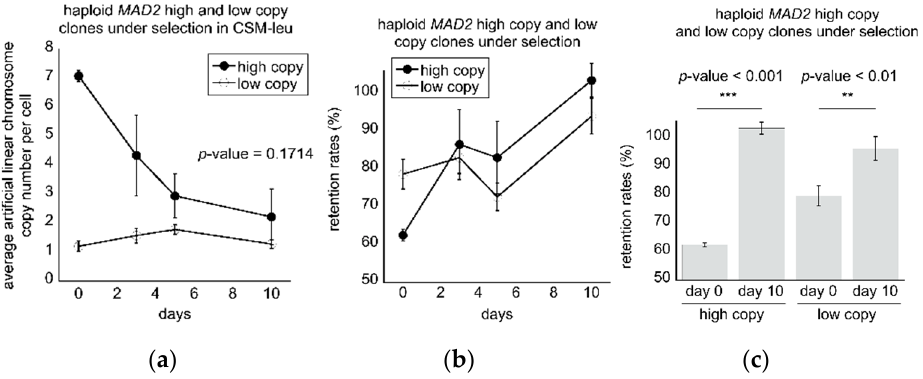
Figure 3. Wild type MAD2 haploid high copy-low retention rate clones evolved towards low copy-high retention rate clones under CSM-leu selection: ( a ) A comparison of average chromosome copy numbers in 2 high copy-low retention rate MAD2 clones with 3 low copy-high retention rate MAD2 clones over 10 days where values are displayed as the mean ± standard deviation. At day 10 there is no significant difference in the artificial chromosome copy numbers per cell ( p -value = 0.1714, Student’s t -test); ( b ) A comparison of 2 high copy-low retention rate MAD2 clones with 3 low copy-high retention rate MAD2 clones over 10 days where values are displayed as the mean ± standard deviation; ( c ) Both populations displayed a significant increase in the retention rates by the 10-day point relative to the starting point at day 0 when grown under CSM-leu selection ( p -values < 0.001 denoted by *** and < 0.01 denoted by ** respectively, Student’s t -test).